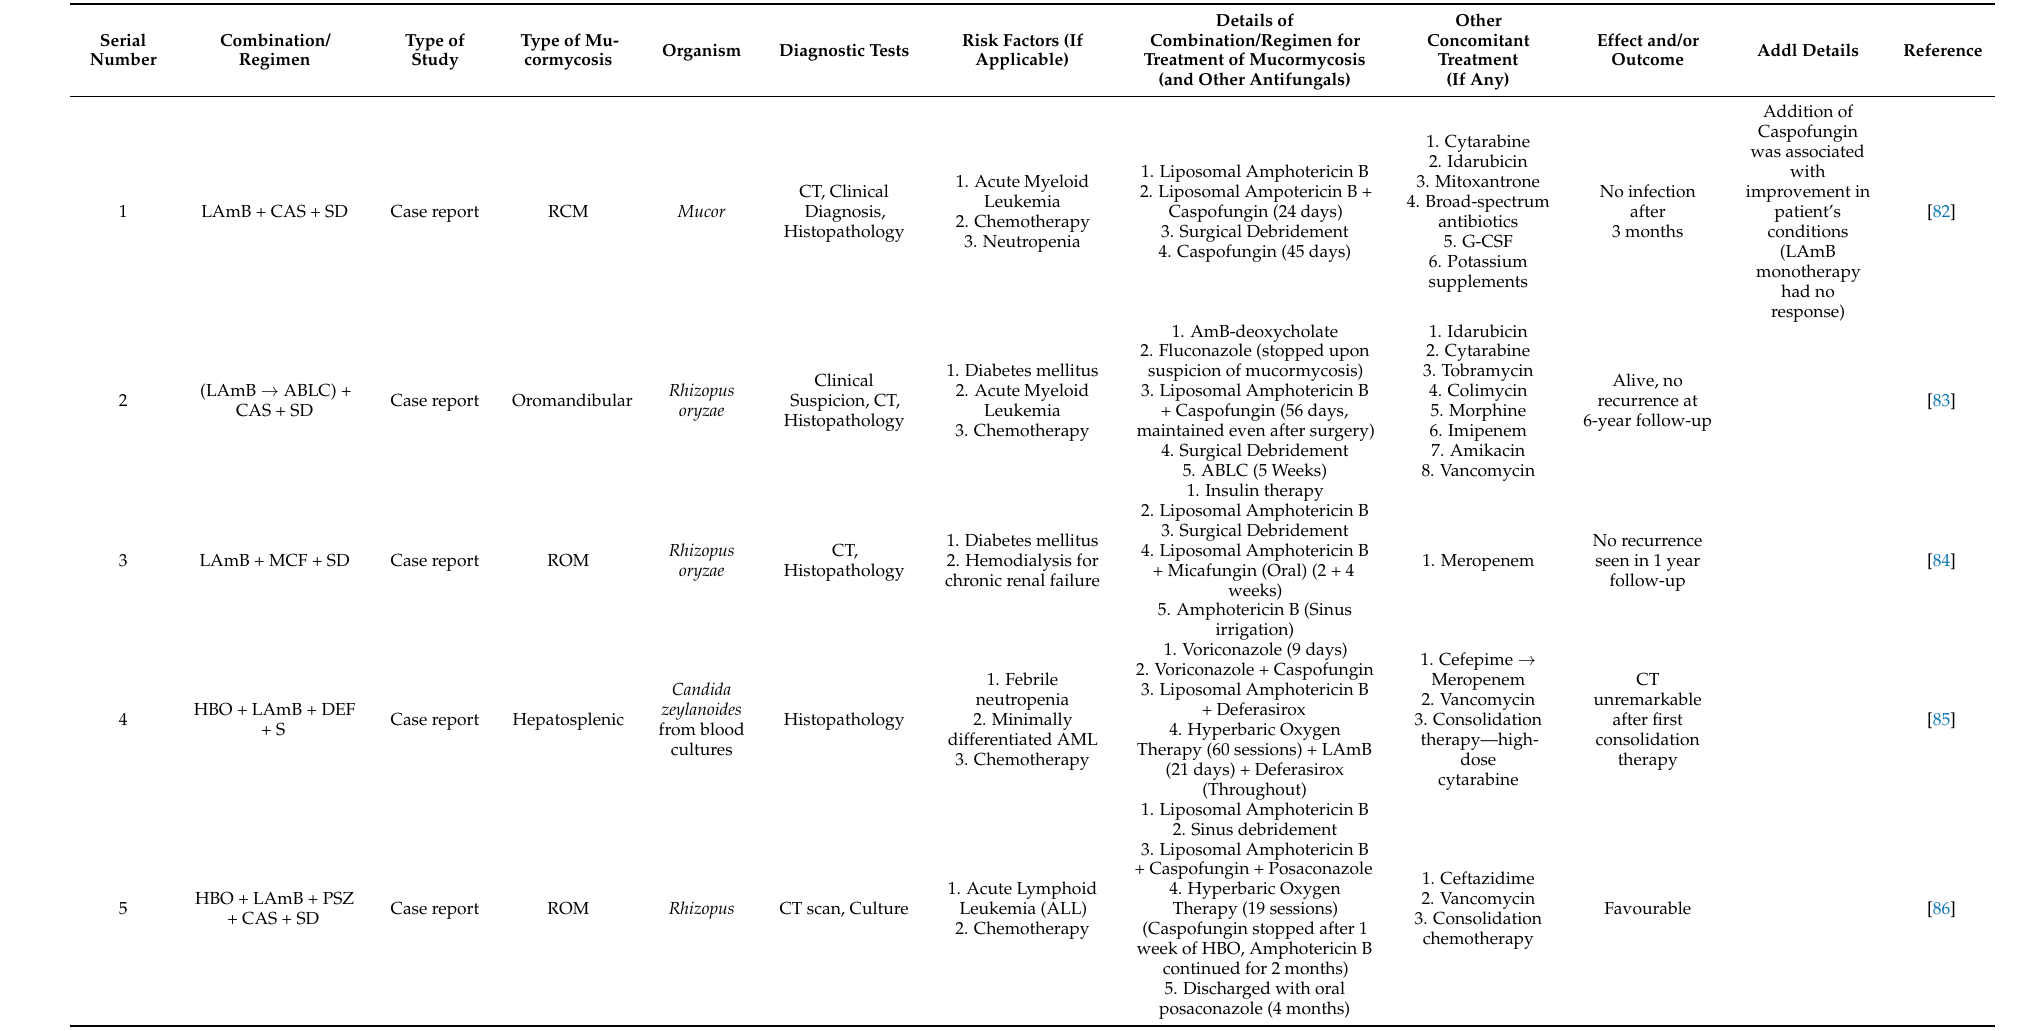
Table 1. Drug Combinations used against different types of